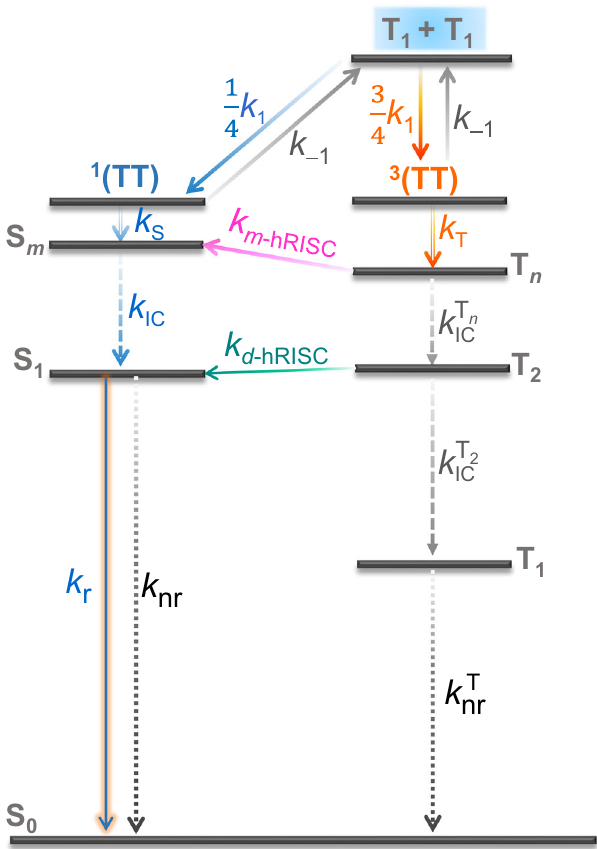
Fig. 7 | Schematic illustration of triplet dynamics. Detailed triplet exciton dynamics diagram in the TPANI-based Device